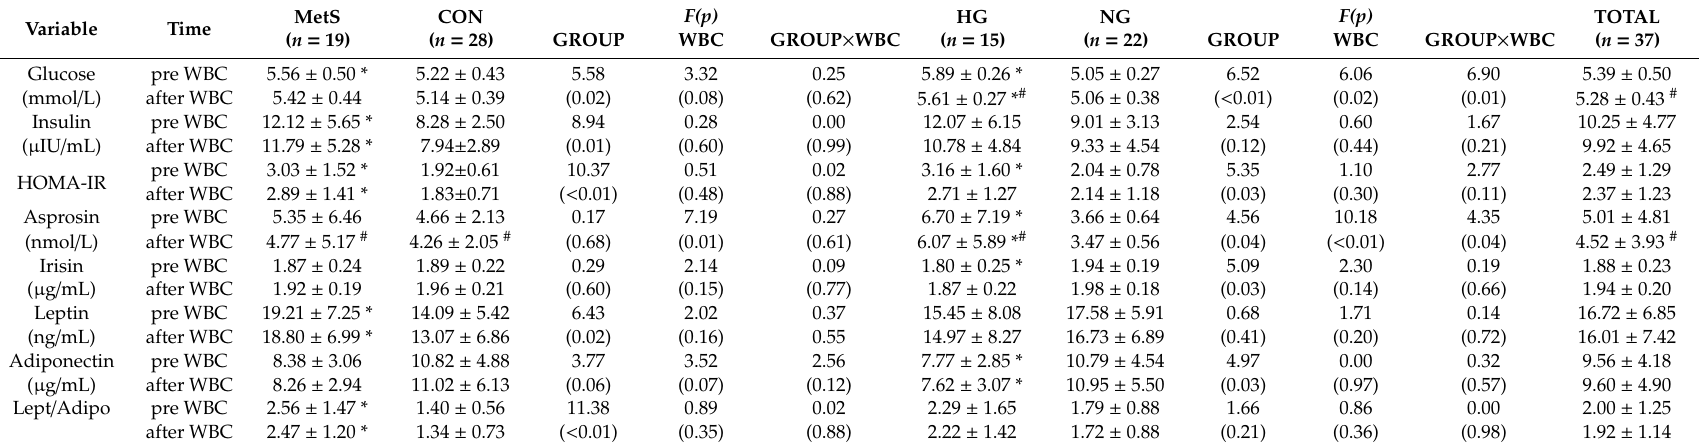
Table 4. Comparison of changes in concentration of glucose, selected hormones, and insulin resistance index (HOMA-IR) under the influence of whole-body cryotherapy (WBC)